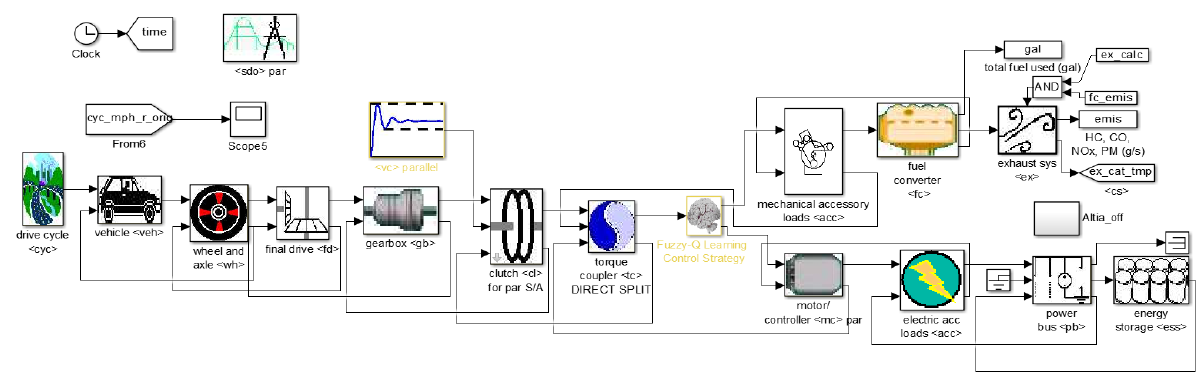
Figure 4. HEV model in ADVISOR.